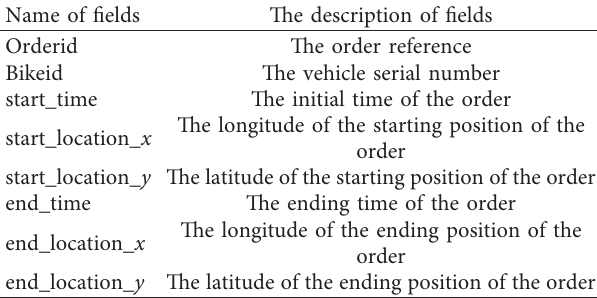
Table 2: The description of